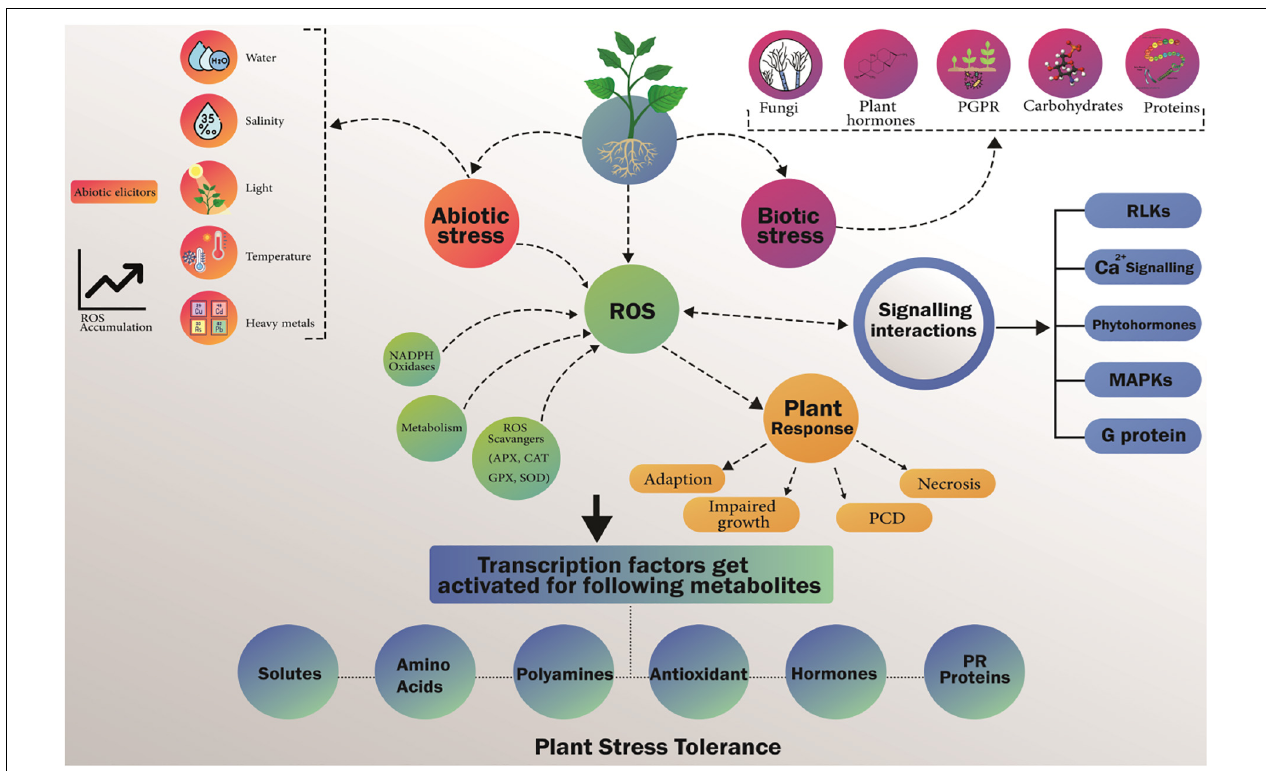
FIGURE 3 | Hypothetical outline of biotic and abiotic stress factors and metabolites produced in response to encounter these factors and create stress tolerance. Metabolites production is up regulated in reaction to a number of biotic and abiotic stresses. This shows significance of metabolites in synchronize plant responses to environmental stresses. Environmental stresses stimulate sensors/receptors due to which reactive oxygen species (ROS) are produced. Variety of metabolites is produced to overcome stress produced by ROS which ultimately initiate cascades of regulatory mechanism resulting which transcription factors get